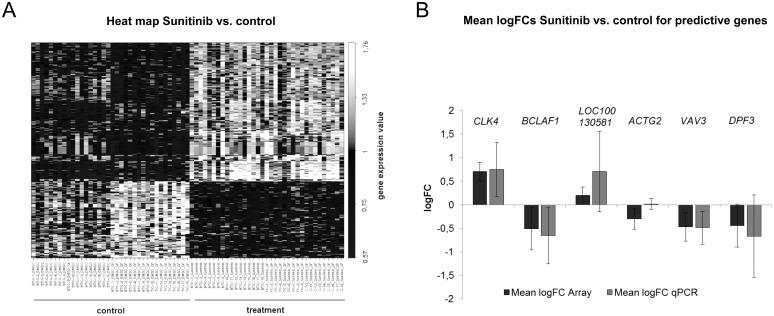
Heterogeneity of expression response to Sunitinib treatment.(A) Shown is a heat map of the 300 most differentially expressed genes when comparing Sunitinib treated with untreated samples. The samples are nicely separated into treated vs. untreated samples. However, the pronounced stripes in the heat map indicate that the vast majority of genes change expression only in subsets of cases. (B) The mean logFCs between control and Sunitinib treated samples for the predictive genes (CLK4, BCLAF1, LOC100130581, ACTG2, VAV3, DPF3) of 6 BTIC lines was calculated using (i) Microarray data and (ii) β-Actin normalized expression values assessed by qPCR for each individual gene.